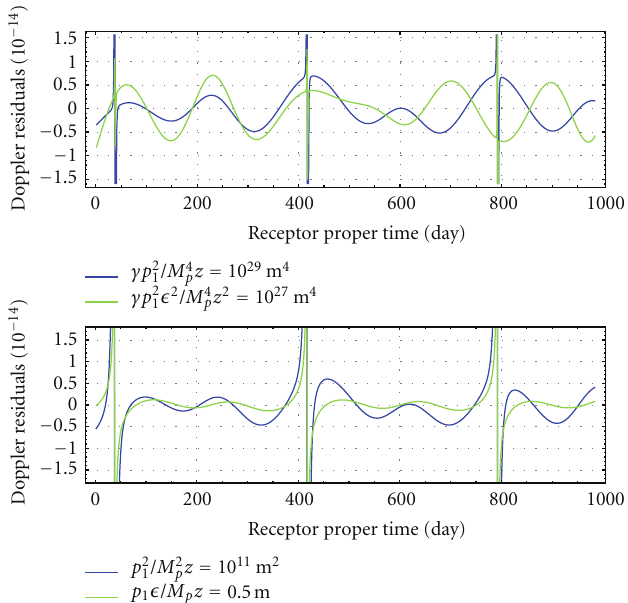
Figure 11: Incompressible anomalous signal due to the di ff erent terms in the metric (23)–(24b) on Cassini Doppler signal with indicated values. The produced residuals are larger than Cassini accuracy (which is 10 − 14 ); therefore these values for the parameters are ruled out.